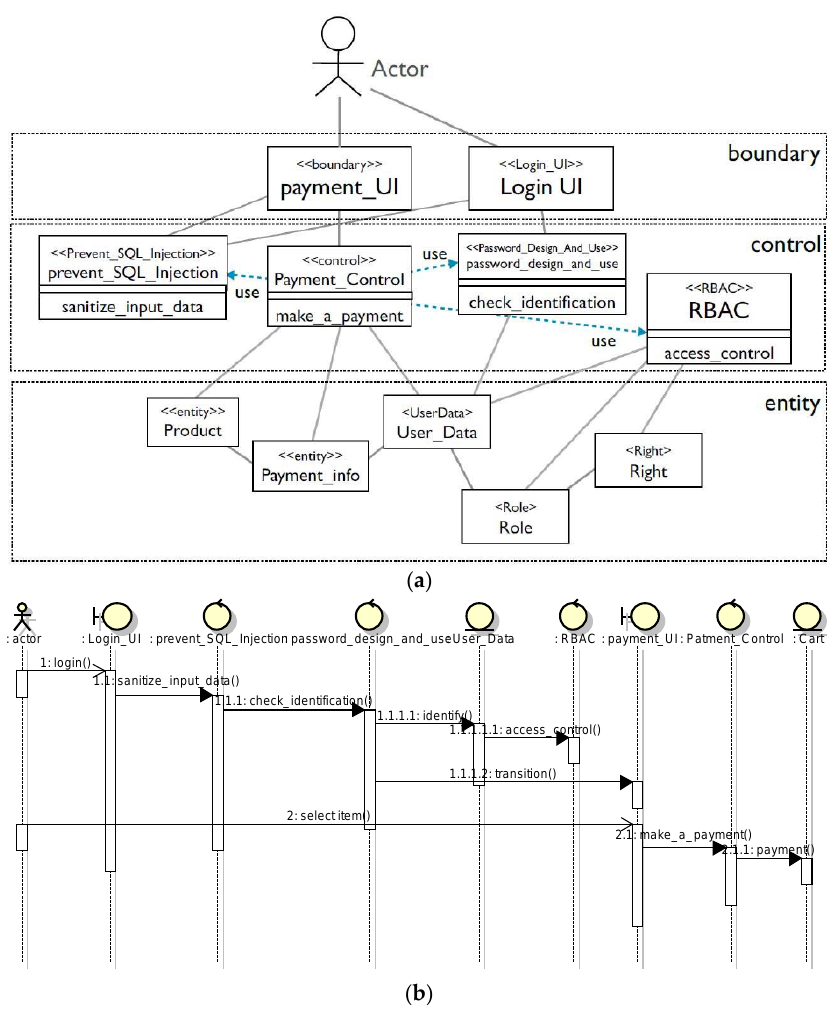
Figure 12. Structure and behavior of a purchasing system. ( a ) Structure; ( b ) Behavior.